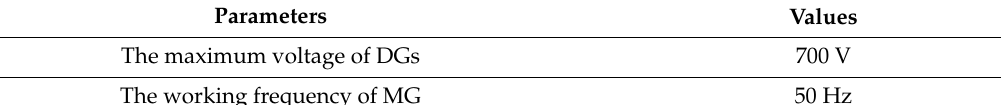
Table 1. The used parameters in experiments.